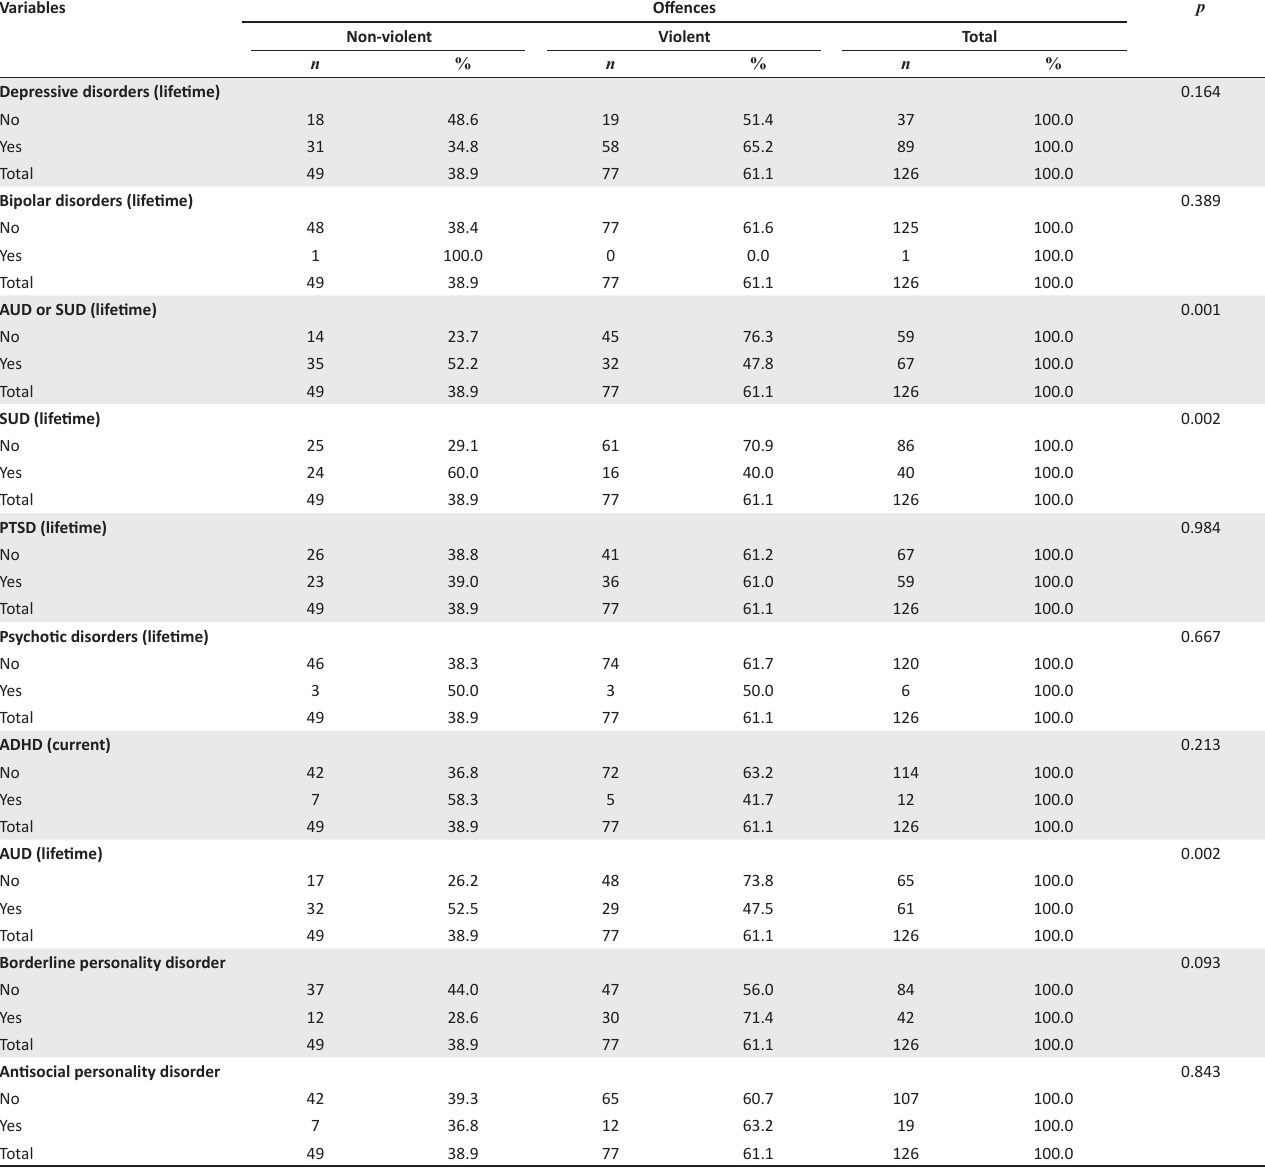
TABLE 4: Associations between offending and mental illnesses and personality disorders.